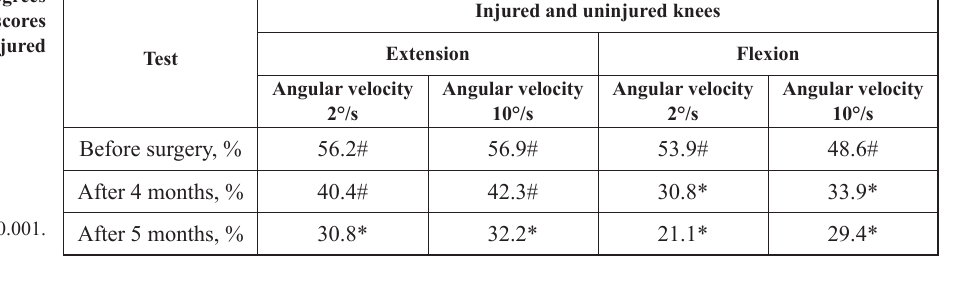
Table 2. The effects of impro- vement of degree in JPS for mean error scores on the injured knee after four and five months of rehabilitation compared with the preoperative data Note. * – p <